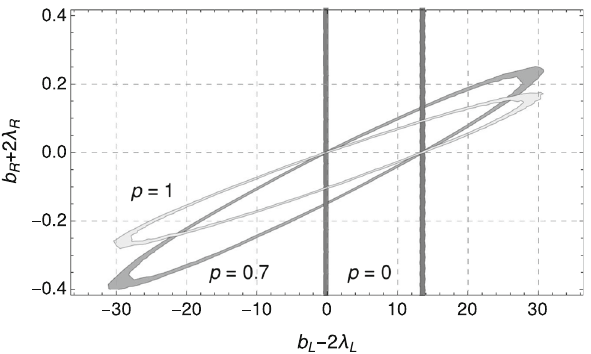
Fig. 14 The 95% C.L. B → X s γ allowed regions of the b and λ parameters when g (cid:2)(cid:2) = 18. The allowed regions form closed elliptical bands; the darkest gray correspond to p = 0, the lightest to p = 1, with p = 0 . 7 in between. When p = 0, only parts of two parallel bands of an “infinite” ellipse can be